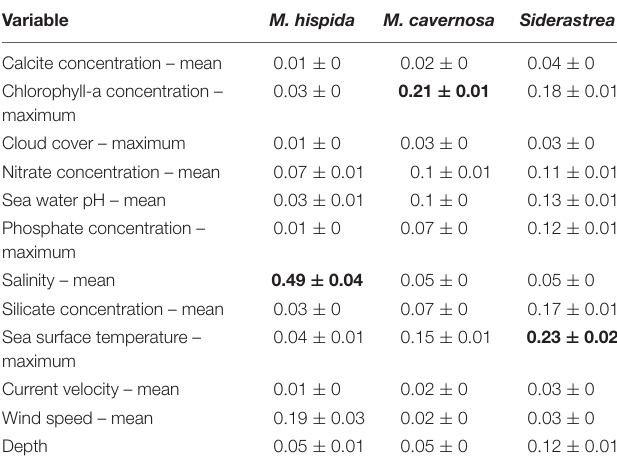
TABLE 2 | Importance of variables used to produce the ensemble